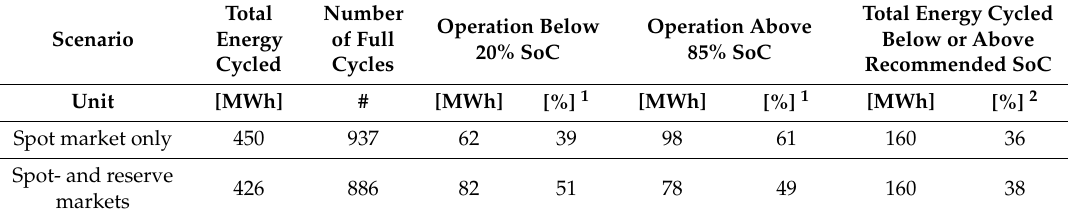
Table 5. Electricity charged below or above the recommended SoC-limits.